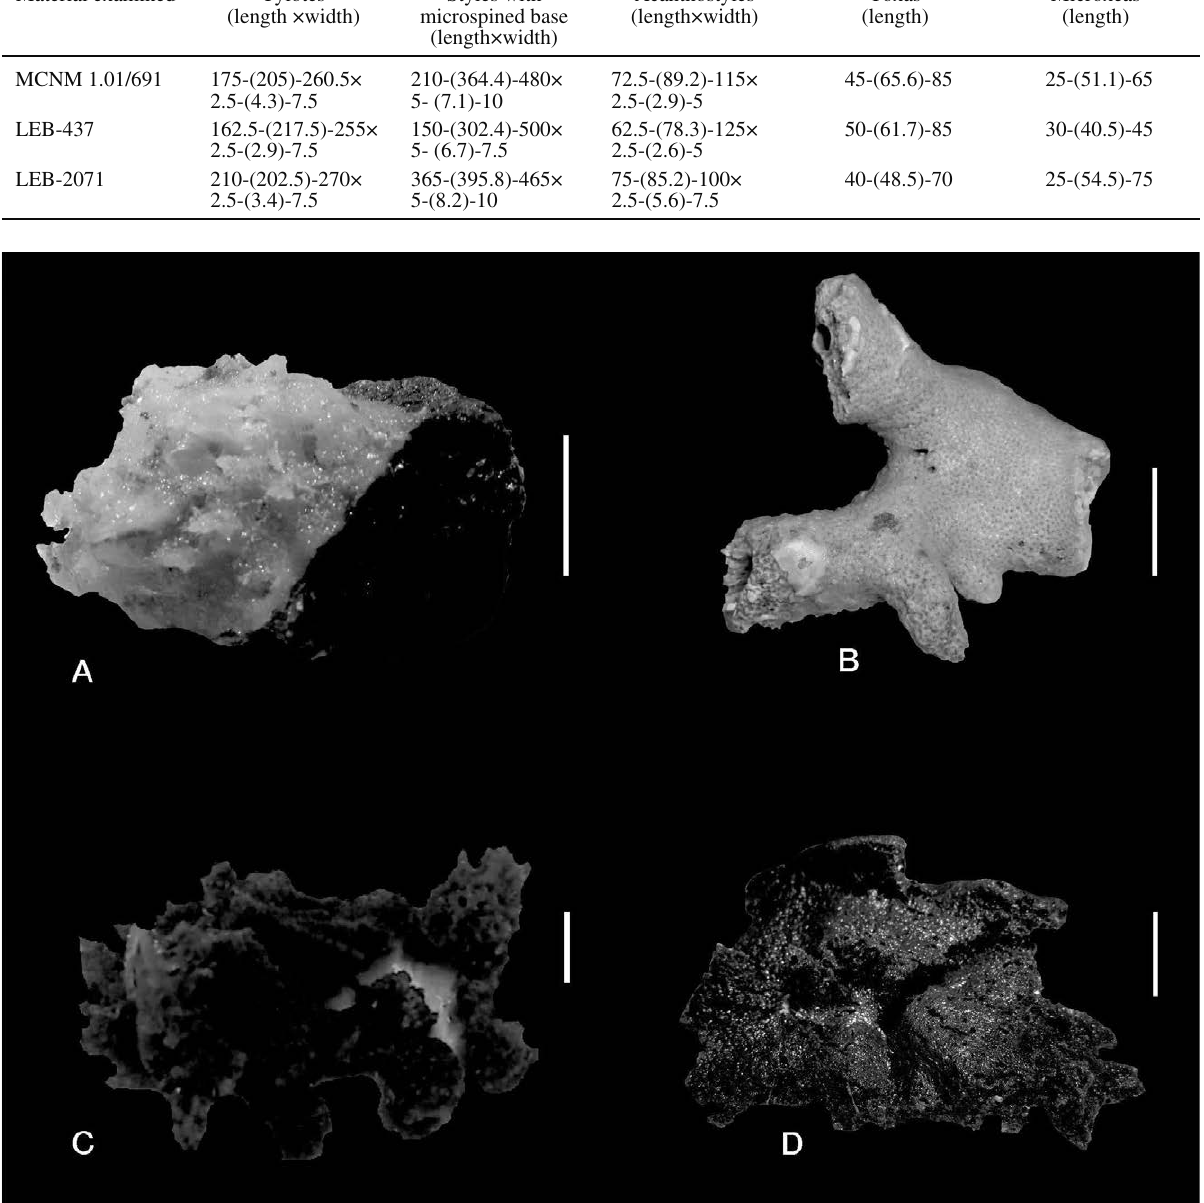
Table 4. – Spicule measurements of Acheliderma fulvum n. sp. Values are expressed in minimum-average-maximum (μm). Material examined